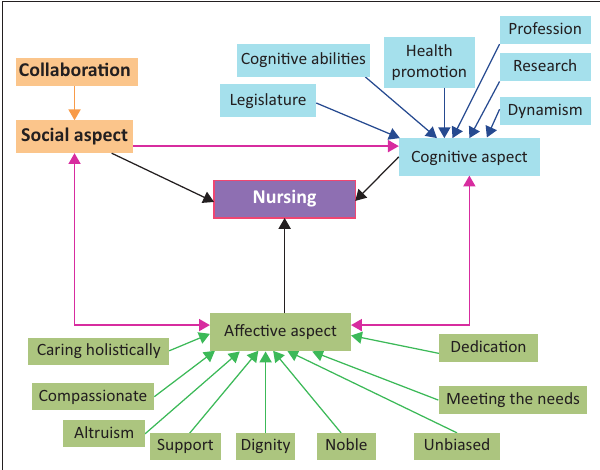
FIGURE 3: Visual concept map of